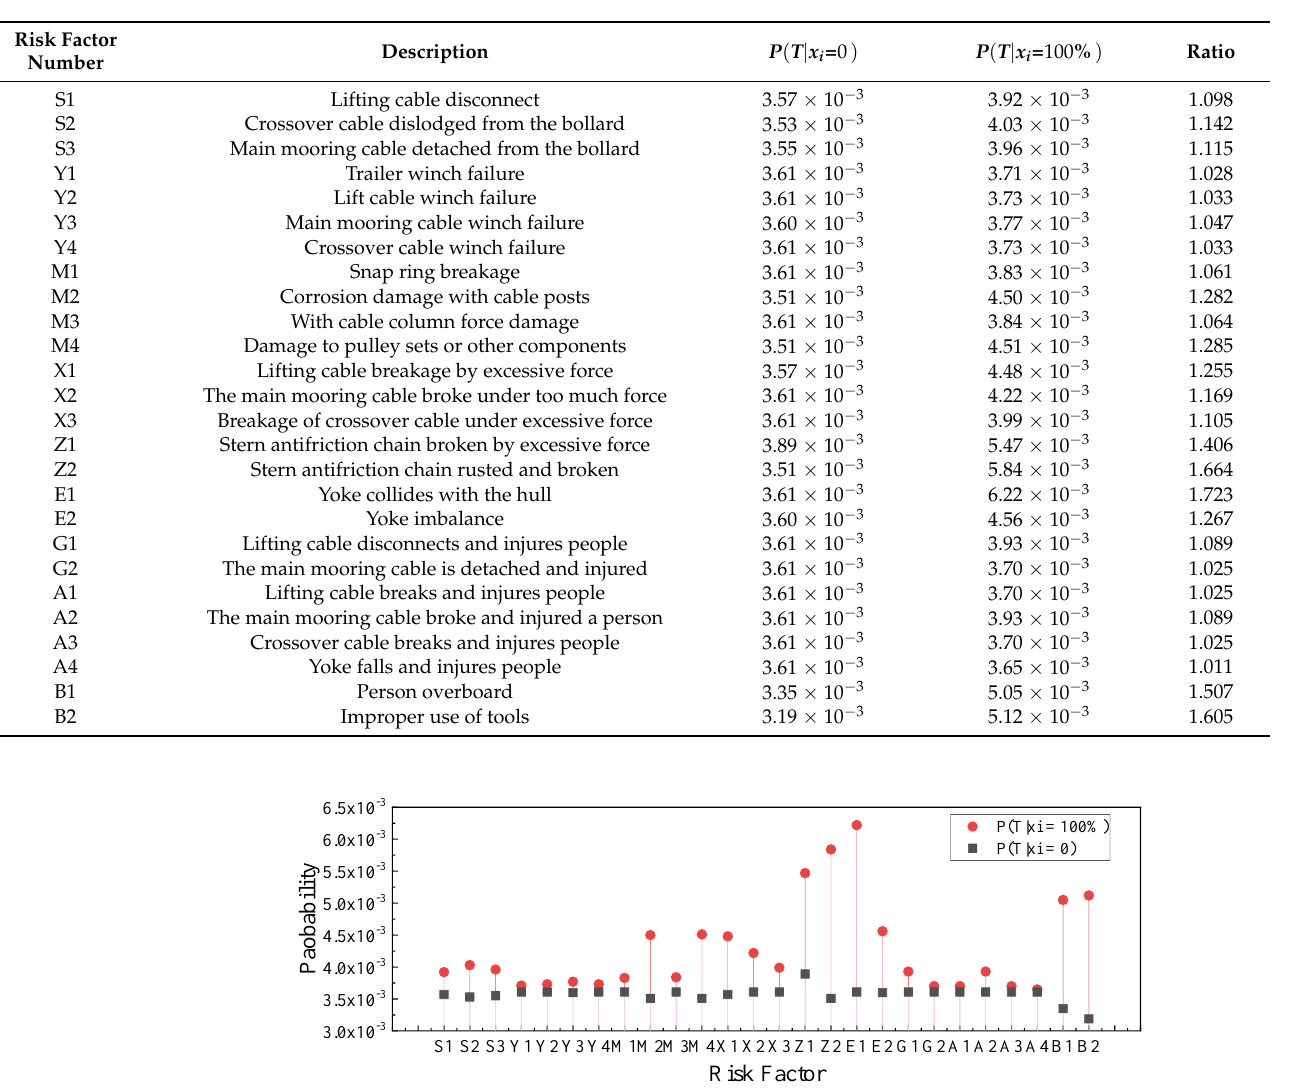
Table 11. Probability table for sensitivity analysis of risk factors.